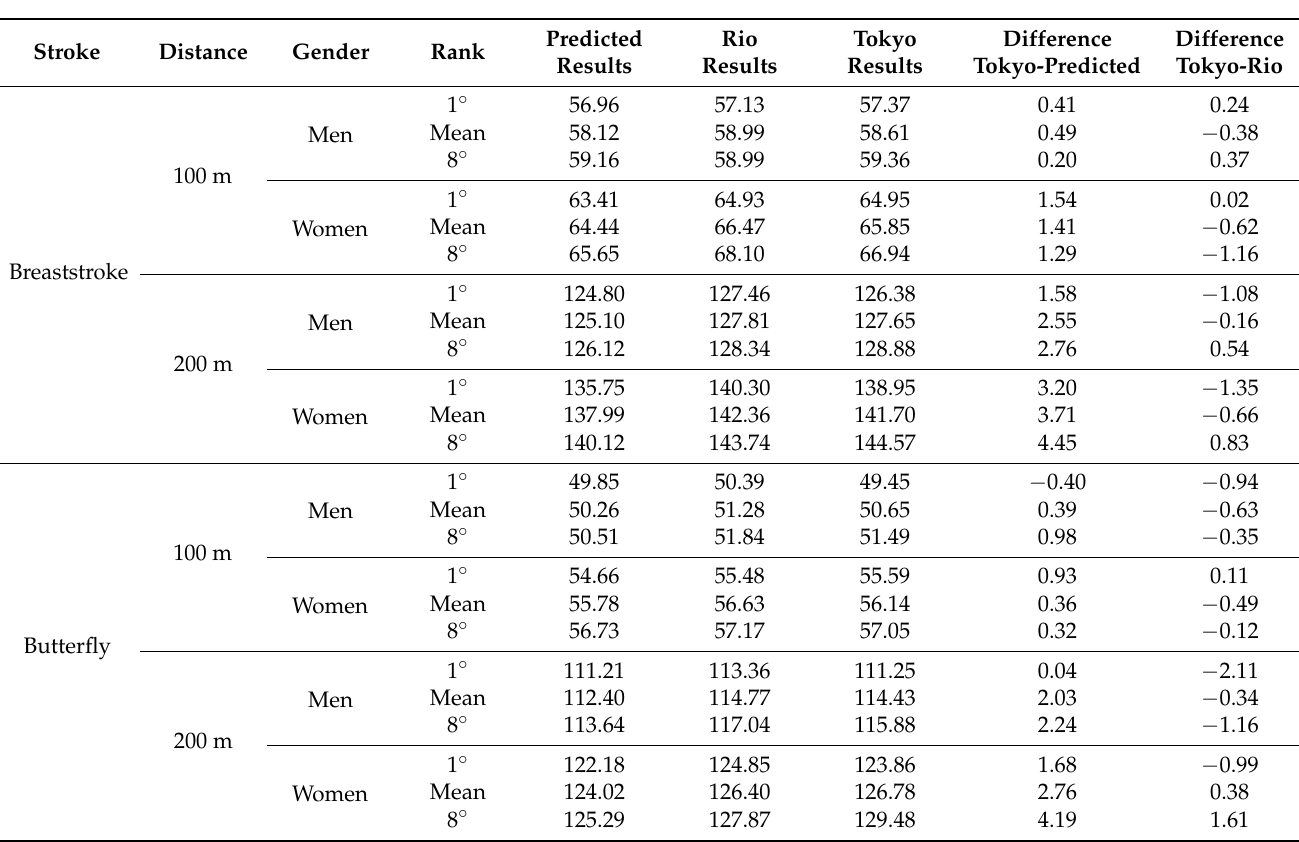
Table 2. Times and differences of predicted, Tokyo and Rio results for winner (1 ◦ ), last (8 ◦ ) and mean of all finalists (Mean) of men and women, 100 m and 200 m, Breaststroke and